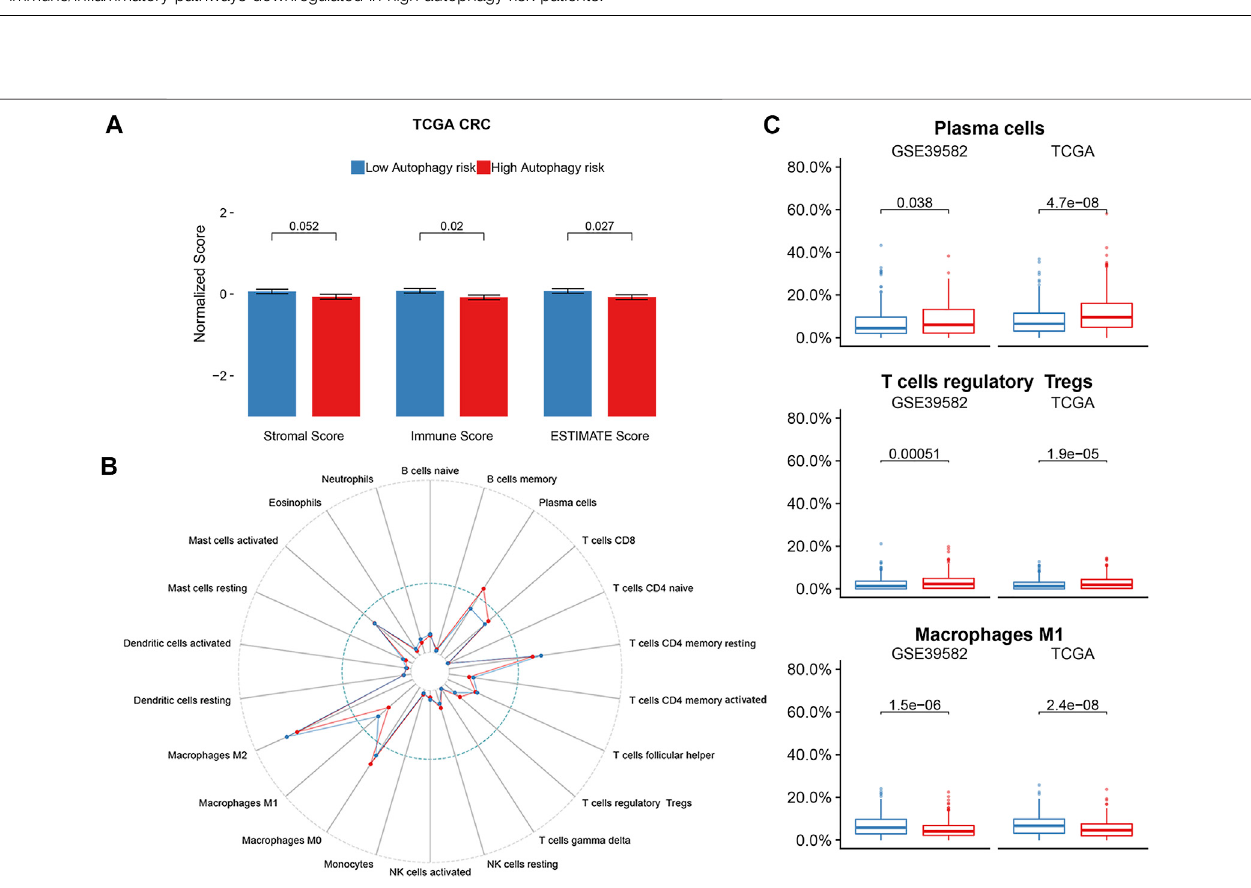
FIGURE 7 | Immune in fi ltration status of ATG signature risk groups. (A) ESTIMATE algorithm in the TCGA cohort. (B) Twenty-two immune cells abundance for different immune risk groups. (C) Plasma cells and T cells regulatory were enriched in the high-risk group. The macrophage M1 was enriched in the low-risk group. p -values are based on the Wilcoxon test. Hazard ratios (HRs) and 95% CIs are for low vs. high autophagy risk. CRC, colorectal cancer; DFS, disease-free survival.